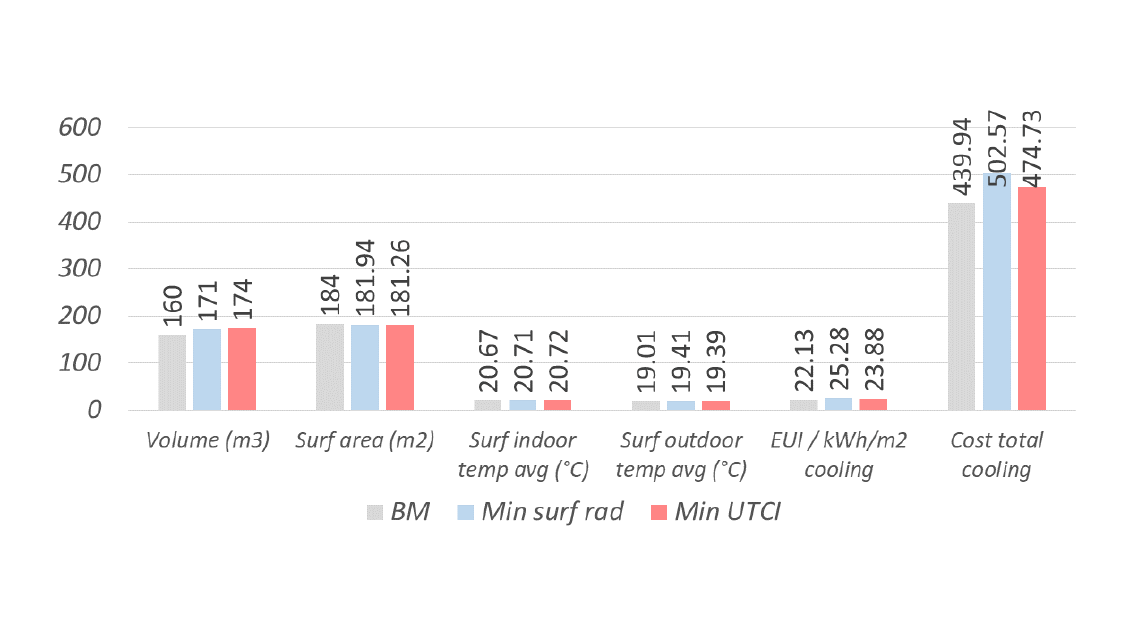
Fig. 12. Trend in energy consumption of cooling for each model.